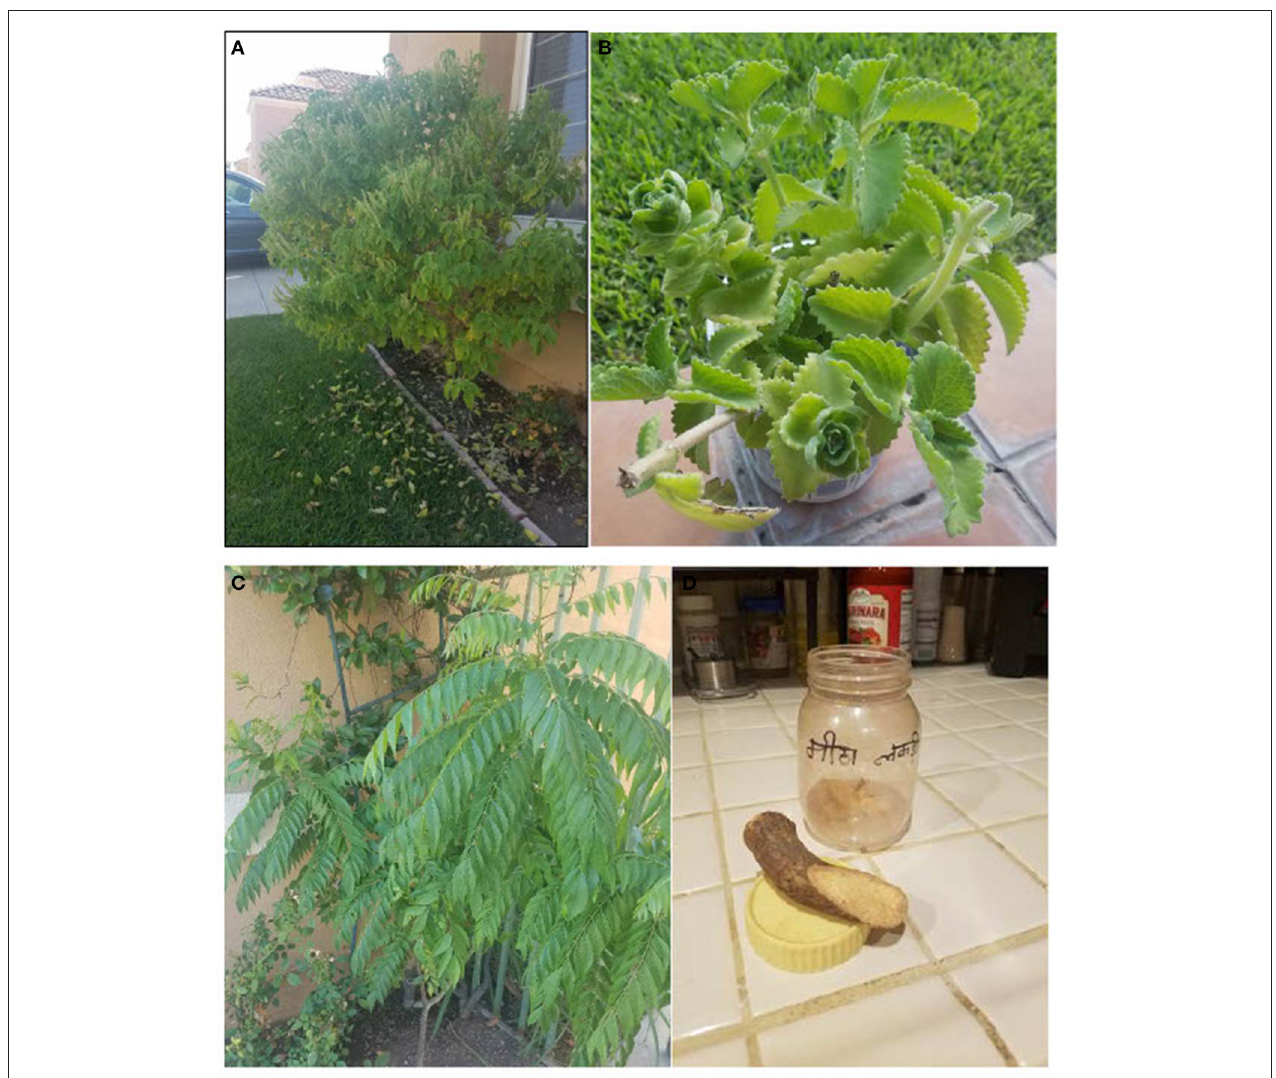
FIGURE 3 | Home sources of selected herbs by southern California Indian immigrant women. (A) Tulsi in homegarden; (B) Karpuravalli in homegarden; (C) Curry leaf tree in homegarden; (D) Meeta lagdhi (licorice root) brought from